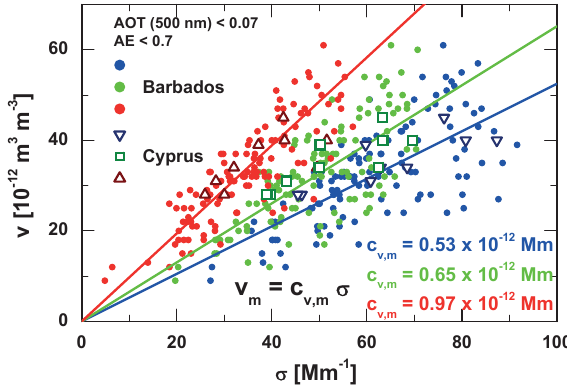
Figure 3. Relationship between particle extinction coefficient σ m and particle volume concentration v m for pure marine cases mea- sured at the AERONET station of Ragged Point, Barbados (circles; 123 observations on 91 different days in the period from August 2007 to February 2015), and at Limassol (triangles for 355 and 1064nm, squares for 532nm; nine observations on 4 different days in the period from July 2011 to June 2015). Correlations are shown for 355nm (blue), 532nm (green), and 1064nm extinction coeffi- cients (red). The slope of the lines indicate the mean increase of v m with σ m for the Barbados data set. The respective conversion factors c v , m for the three laser wavelengths are given as numbers. They are also listed in Table